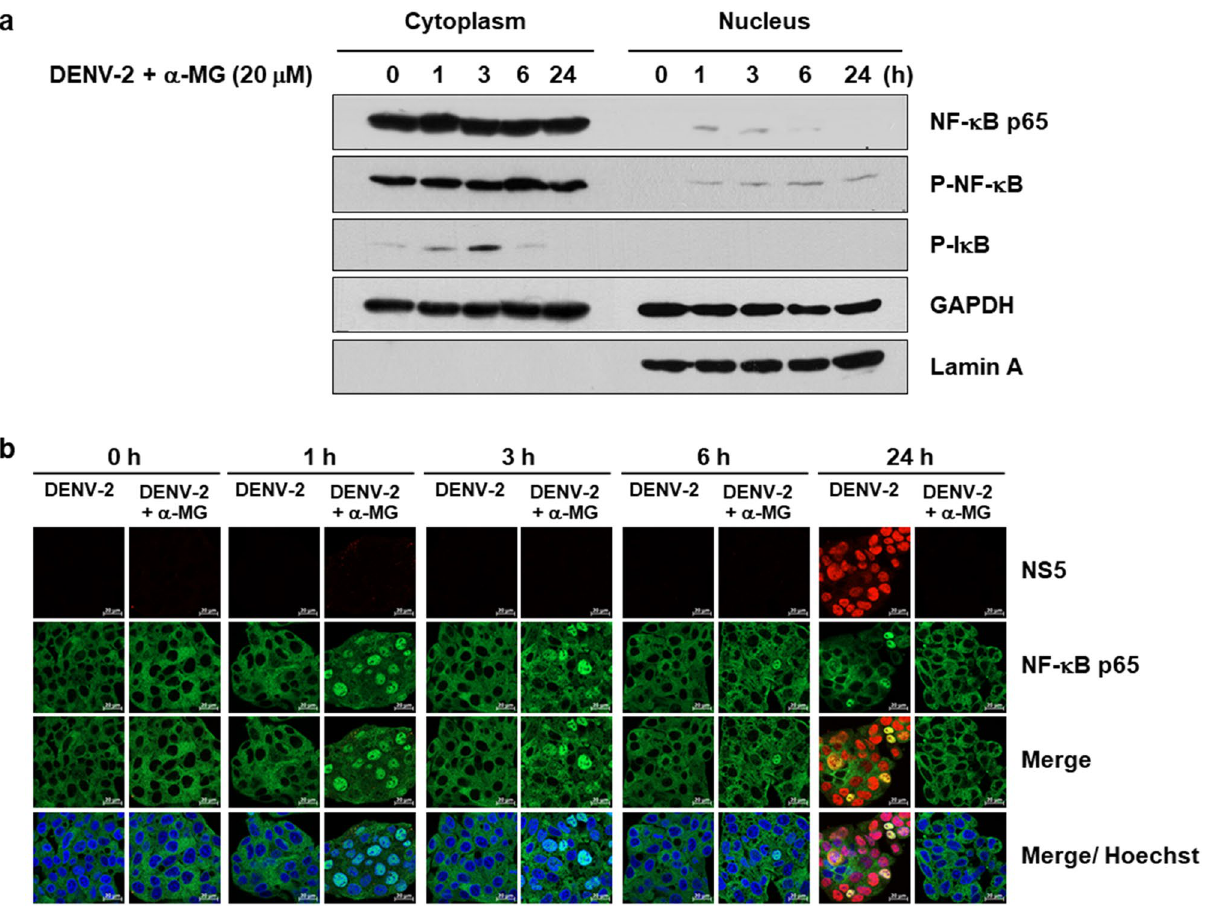
Figure 7. α-MG suppresses NF-κB activation. HepG2 were infected with DENV-2 at a MOI of 5 and treated with 20 μM of α-MG. The cells were harvested at 0, 1, 3, 6, and 24 h after treatment. ( a ) Cell lysates were separated into cytoplasmic and nuclear fractions. The expressions of NF-κB p65, phosphorylated NF-κB (P-NF-κB), and phosphorylated IκB (P-IκB) were determined by immunoblot assay using anti-NF-κB p65, anti- P-NF-κB, and anti-P-IκB antibodies, respectively. ( b ) Immunofluorescence assay demonstrates the expression and intracellular localization of NF-κB p65 (green) and DENV NS5 (red). Hoechst stain was used for nuclear staining (blue). Images are representative of three independent